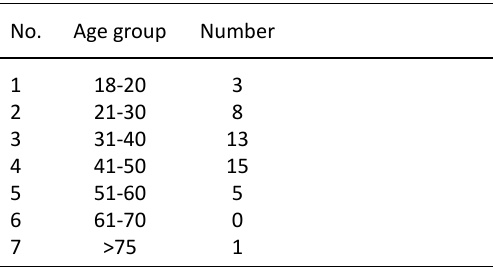
Table 4. Annual health examination data among food